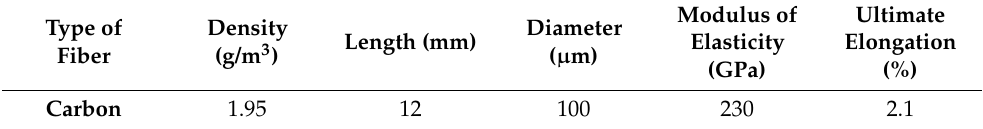
Table 4. Carbon fiber